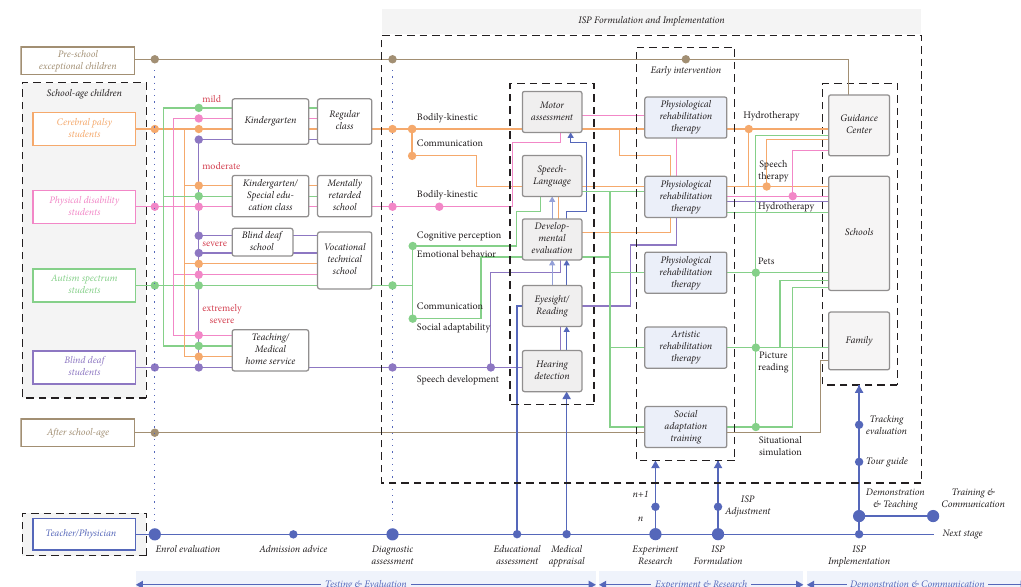
Figure 8: Flow chart of behavior of various